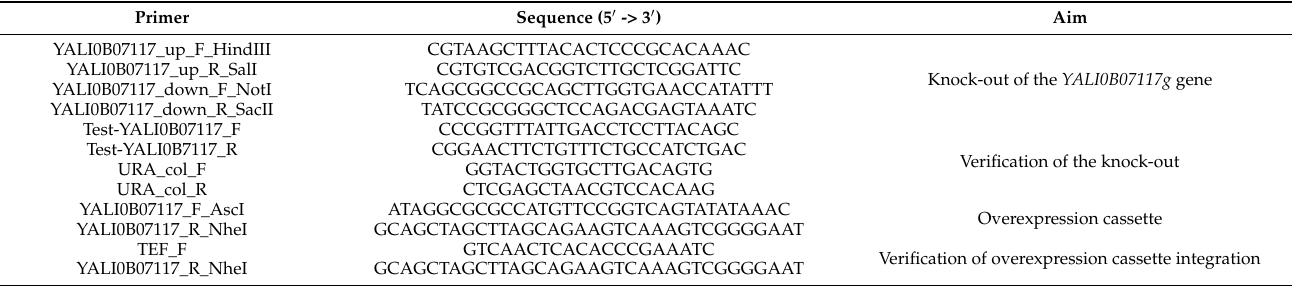
Table 4. Primers used in this